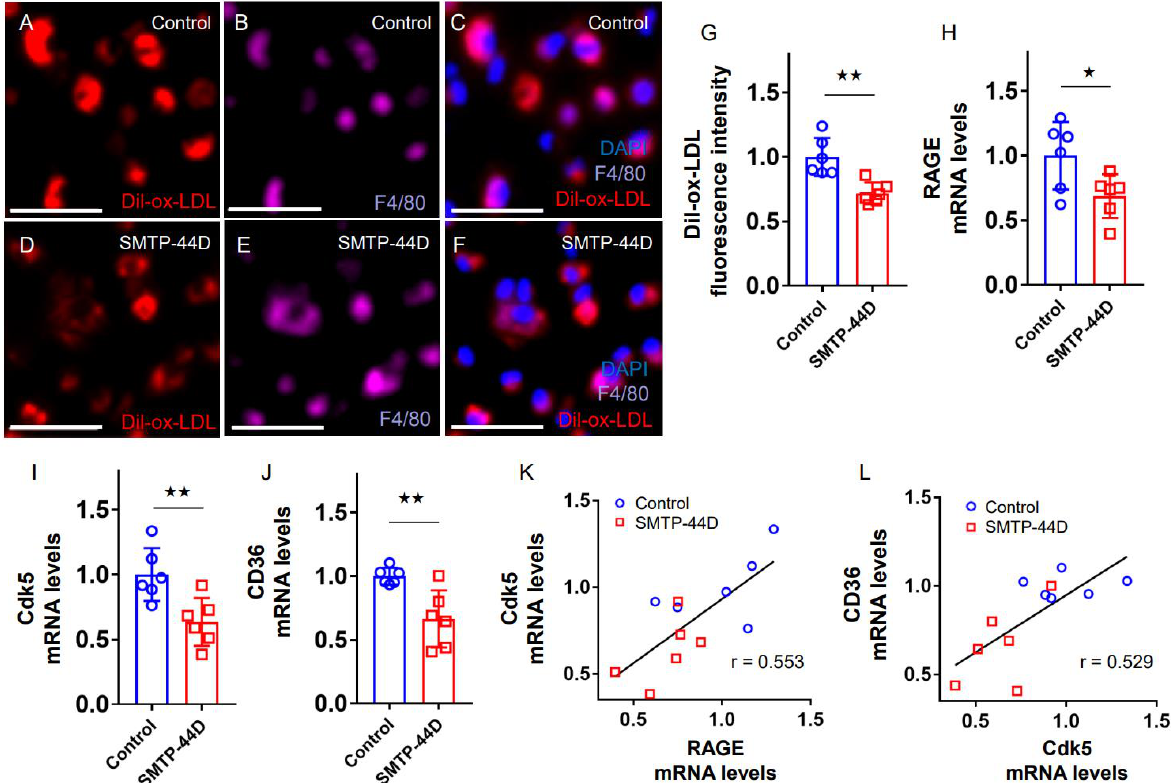
Figure 3. Effects of SMTP-44D on Dil-ox-LDL uptake into, and RAGE , Cdk5 , and CD36 gene expression in, Apoe −/− mice. Peritoneal macrophages were extracted from Apoe −/− mice injected with SMTP-44D at 30 mg/kg/day or saline every other day for 4 weeks. ( A – F ) Representative immunofluorescent staining images in peritoneal macrophages. Dil-ox-LDL positive cells were stained in red ( A , D ), while F4/80 were in purple ( B , E ). ( C , F ) Merge images. Scale bars, 50 μm . Quantification of fluorescence intensity in red. Dil-ox-LDL uptake was shown as a relative value compared to control mice ( G ). Gene expression levels of RAGE ( H ), Cdk5 ( I ), and CD36 ( J ) derived from Apoe −/− mice, and their correlation ( K , L ). Total RNAs were reverse-transcribed, and the resulting cDNAs were amplified by real-time PCR. Data were normalized by the intensity of GAPDH mRNA-derived signals and expressed as a relative to the control values. Number = 6 for each group. Error bars are standard deviation. ★ p < 0.05 and ★★ p < 0.01 vs. control.